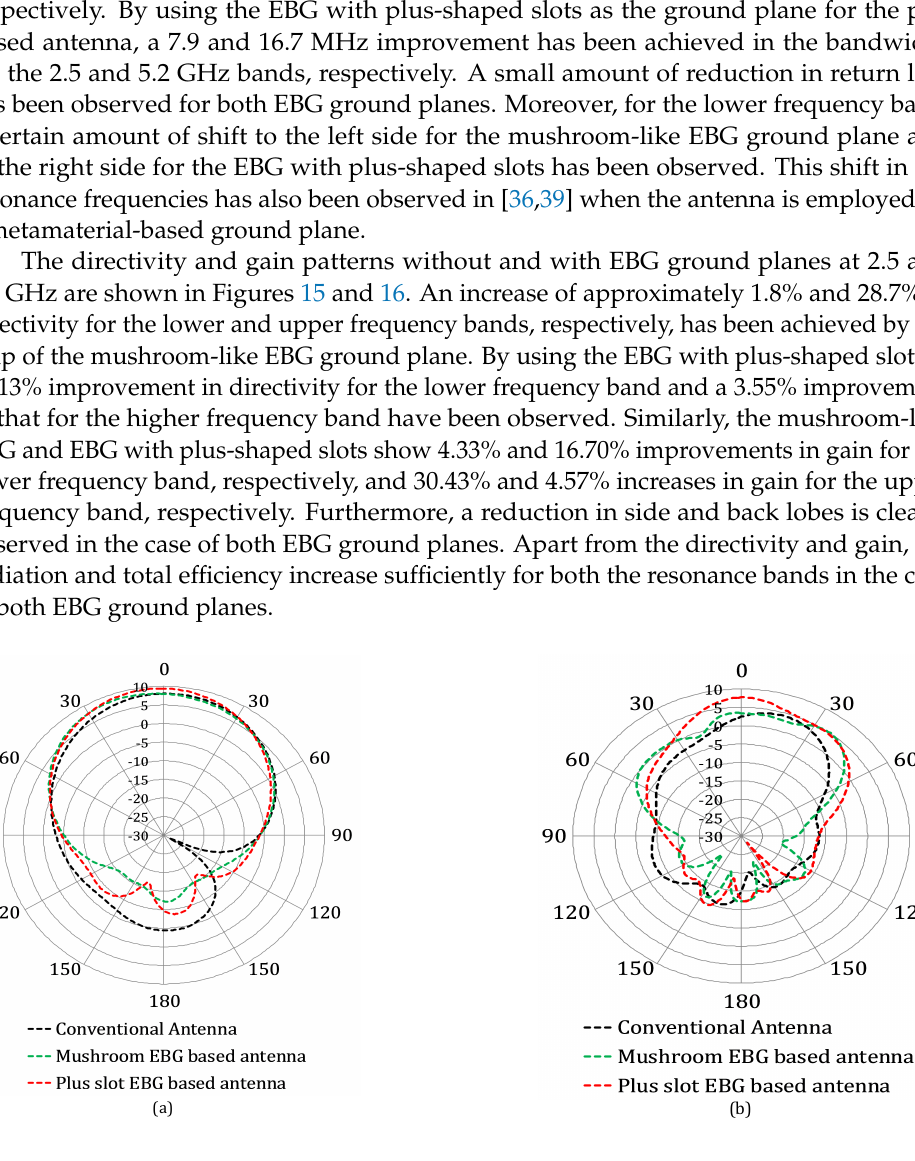
Figure 15. Directivity patterns with and without EBG ground planes at ( a ) 2.5 GHz and ( b ) 5.2